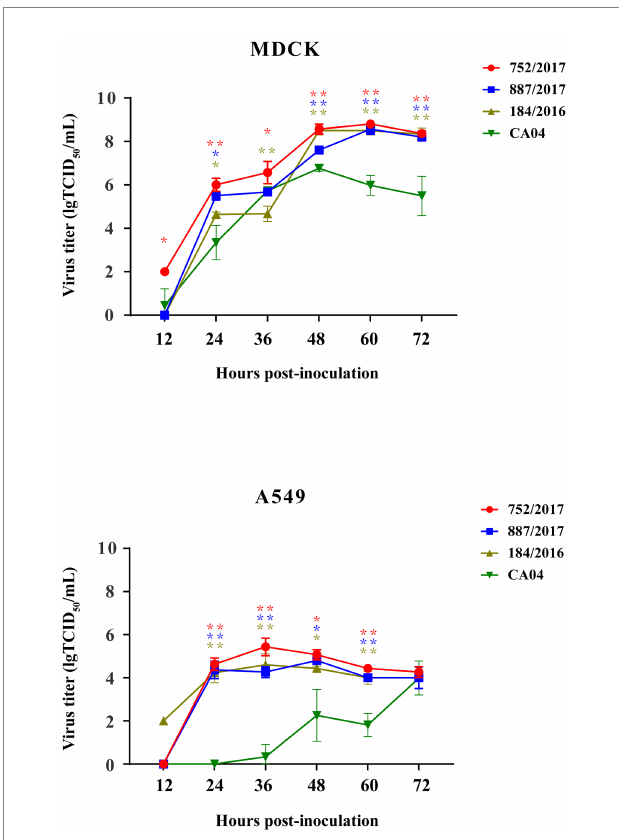
FIGURE 4 Replication kinetics of 887/2017, 752/2017, 184/2016, and CA04 viruses cultured in MDCK cells with MOI 0.001 and A549 cells with MOI 0.01. The data at each time point represent the mean standard deviation of the three independent experiments. The “*” represents significance of difference, ** p < 0.01, * p < 0.05 (Multiple T-test).